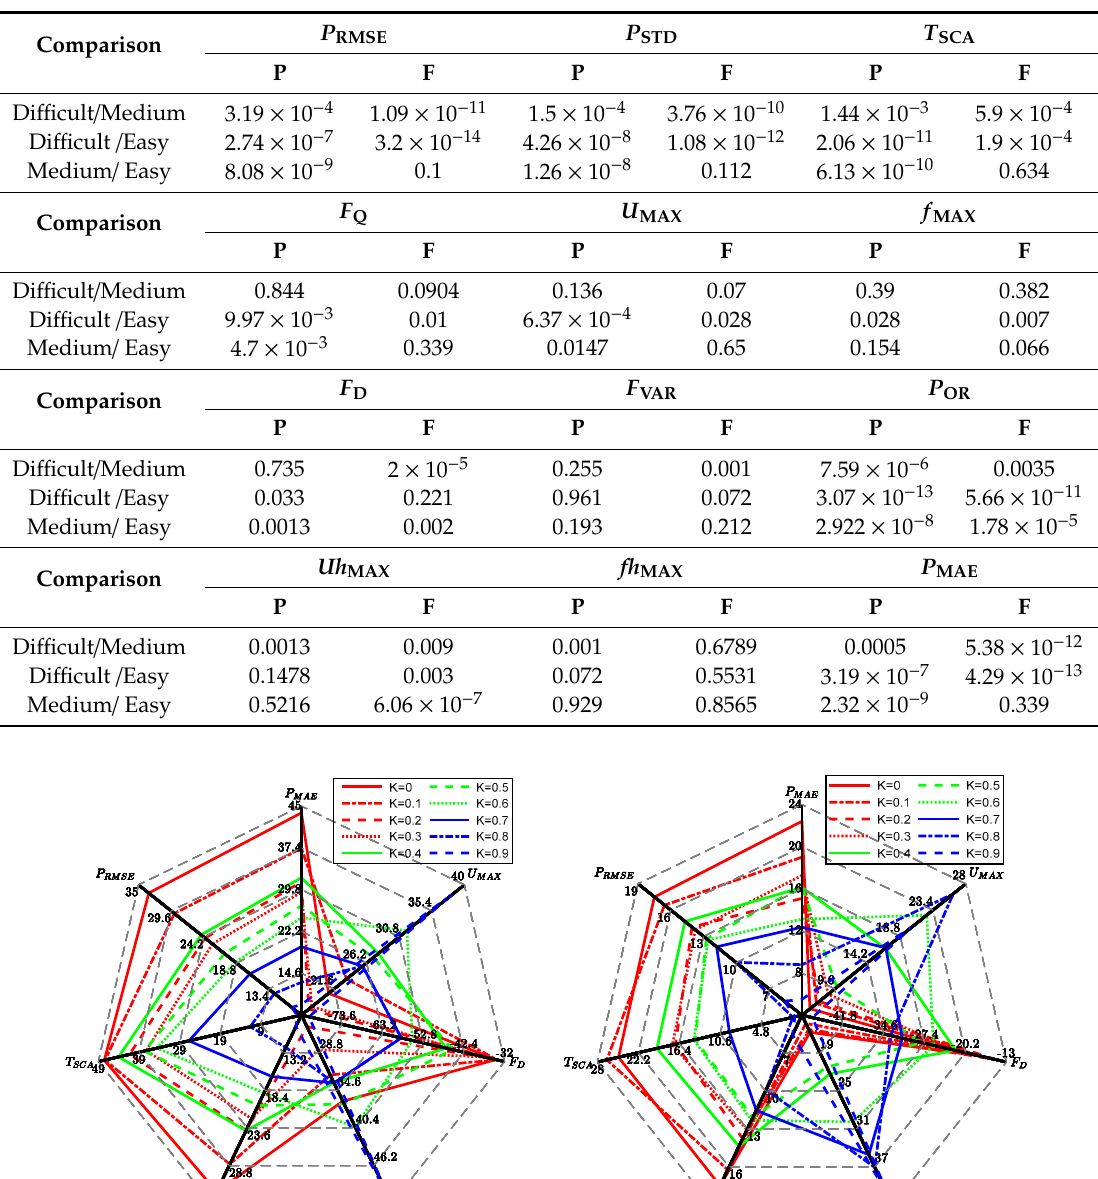
Table 2. Significance comparison of characteristic quantities.